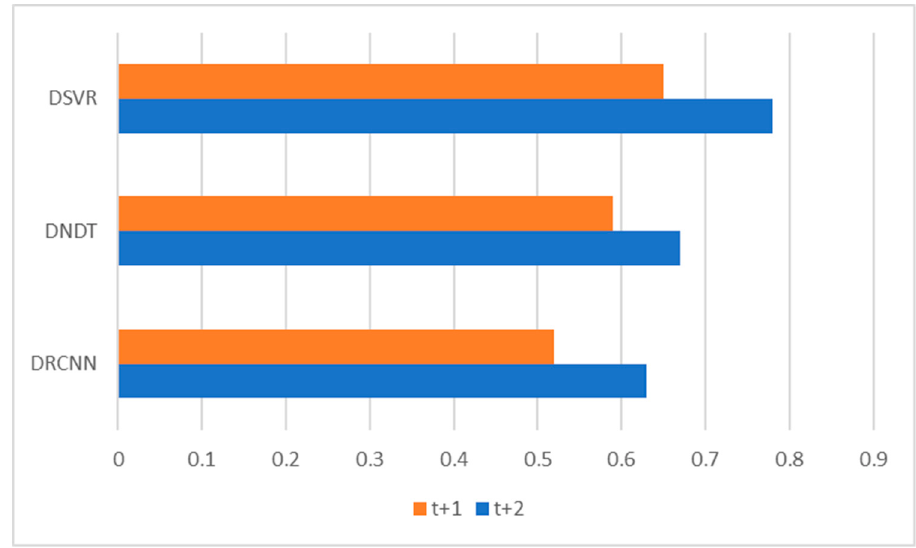
Figure 6. Multiple-step ahead forecasts in forecast horizon: MAPE.